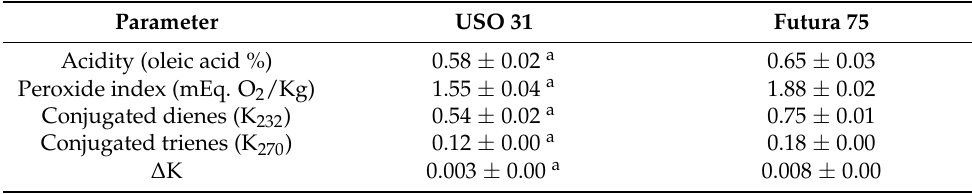
Table 1. Quality parameters of USO 31 and Futura 75 hempseed oil (HSO).